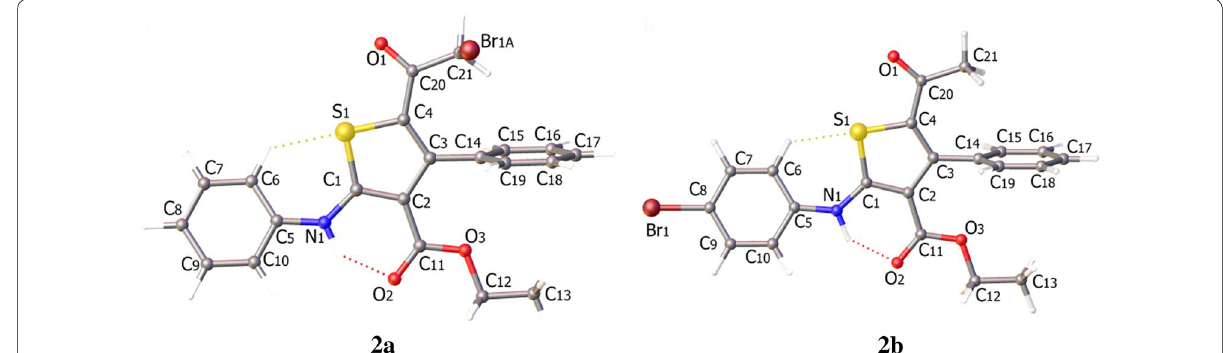
Fig. 5 The optimized structures of studied